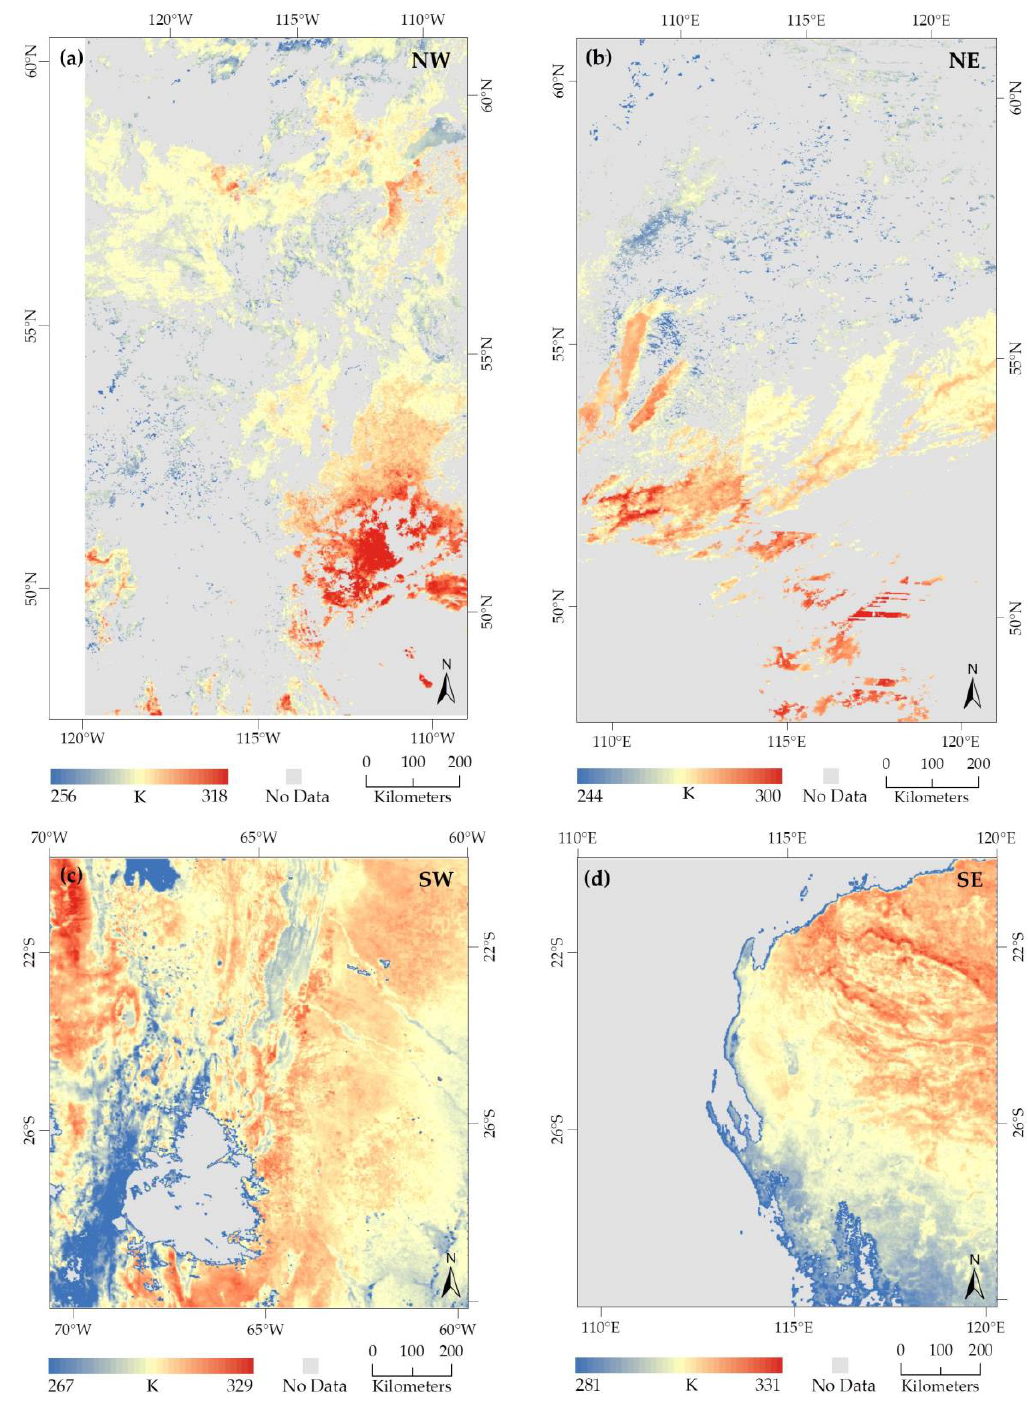
Figure 5. Daily Ts images in Kelvin (K) for the four different AOIs. Each Ts image was derived from the mosaic, reprojection, and subset operations on multiple swath data (i.e., MOD11_L2) for a day in 2019. For example, ( a ) northwestern hemisphere (NW): DOY 236; ( b ) northeastern hemisphere (NE): DOY 275; ( c ) southwestern hemisphere (SW): DOY 273; and ( d ) southeastern hemisphere (SE): DOY 275. Only cloud-free good pixels are shown here and remaining declared as ‘no data’.